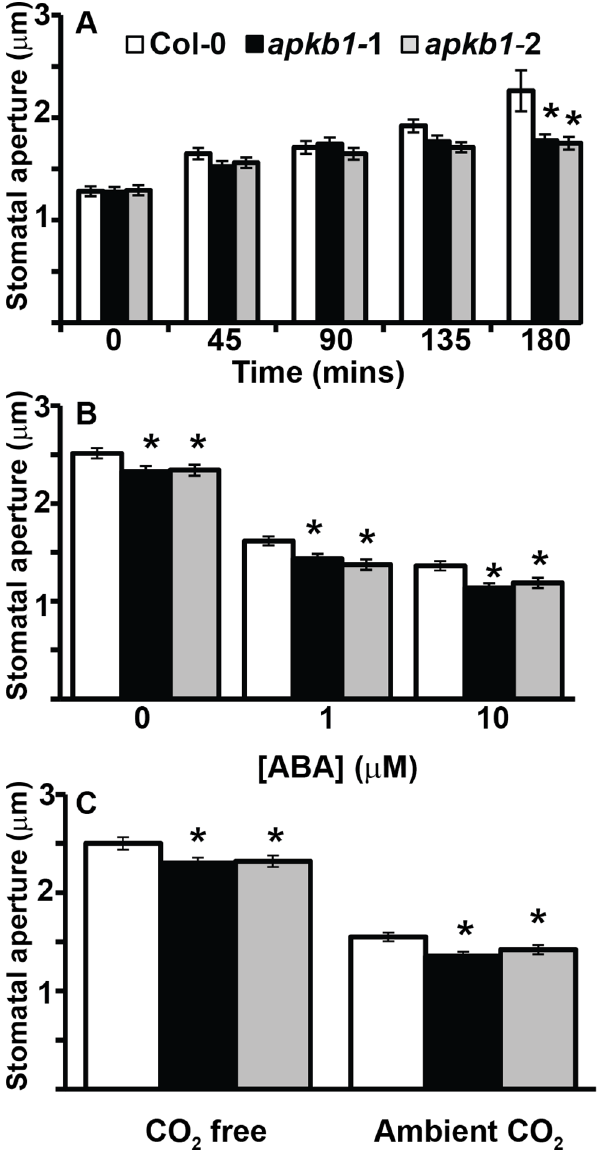
Figure 4. Stomata of plants lacking APK1b cannot open as wide in response to light but can close in response to ABA or CO 2 . The effect of A: light, B: ABA and C: CO 2 on stomatal aperture measurements from apk1b-1, apk1b-2 and control plants. Apertures were measured from detached leaf abaxial peels following treatment with stimuli as indicated. For the response to light shown in A. plants were dark-adapted and peels prepared in dim light at the start of the experiment. Significant differences from Col-0 control are indicated (*=p , 0.05).